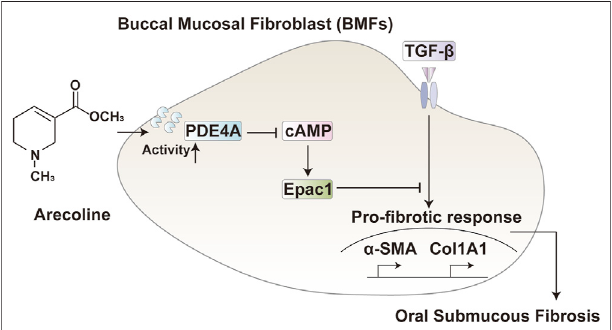
FIGURE 6 | A schematic diagram. In TGF- β activated buccal mucosal fi broblast, arecoline increased the PDE4A activity, therefore inhibiting the cAMP/Epac1 pathway and promoting the oral submucous fi